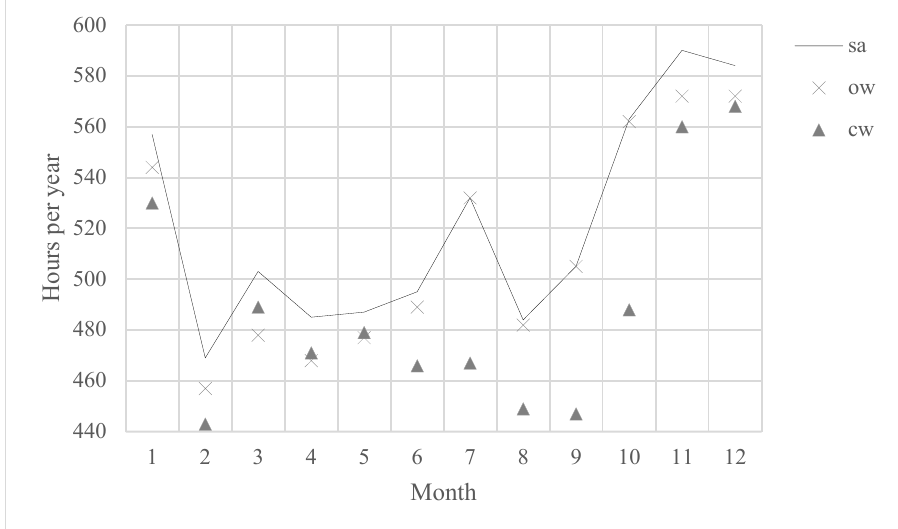
Fig. 3. Comfort hours per month in sub-humid warm